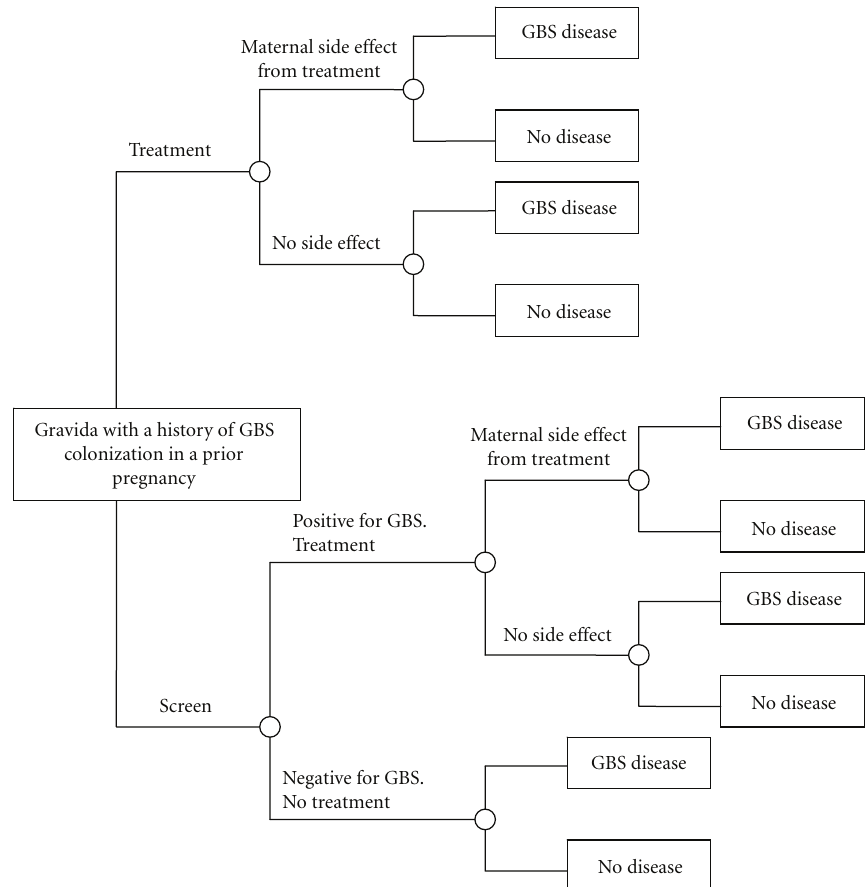
Figure 1: Decision-analysis model for evaluating the cost-e ff ectiveness of screening-directed versus universal treatment of women with group B streptococci (GBS) colonization in a previous pregnancy on prevention of early onset neonatal GBS